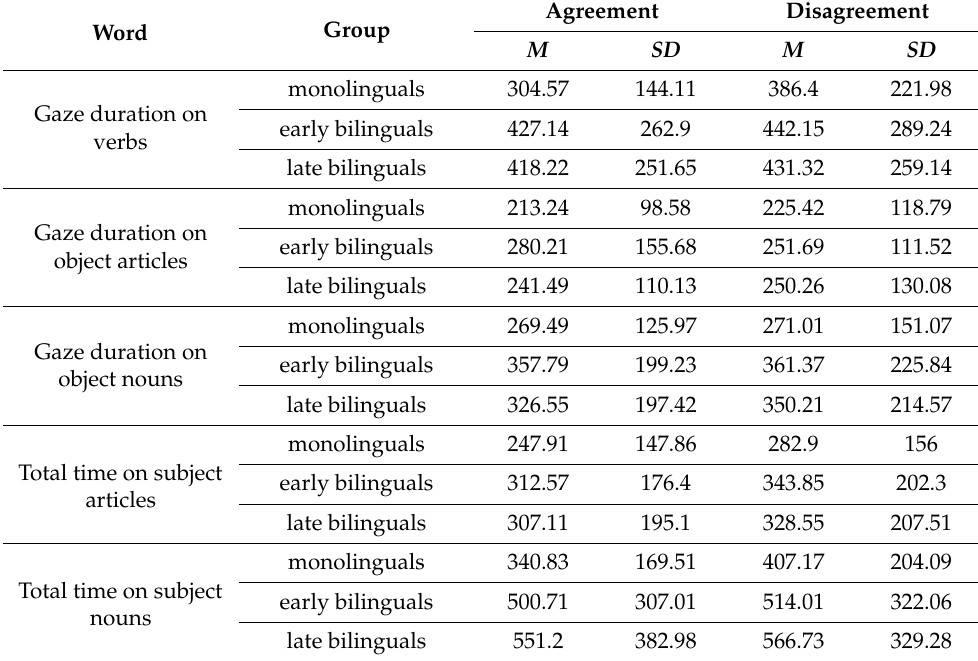
Table 2. Descriptive statistics for gaze duration and total time in